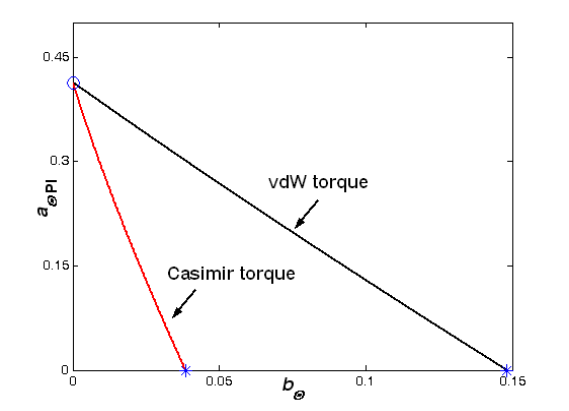
Figure 6. Comparison between vdW and Casimir torques with variation of the pull-in a with parameter b parameter PI Θ Θ